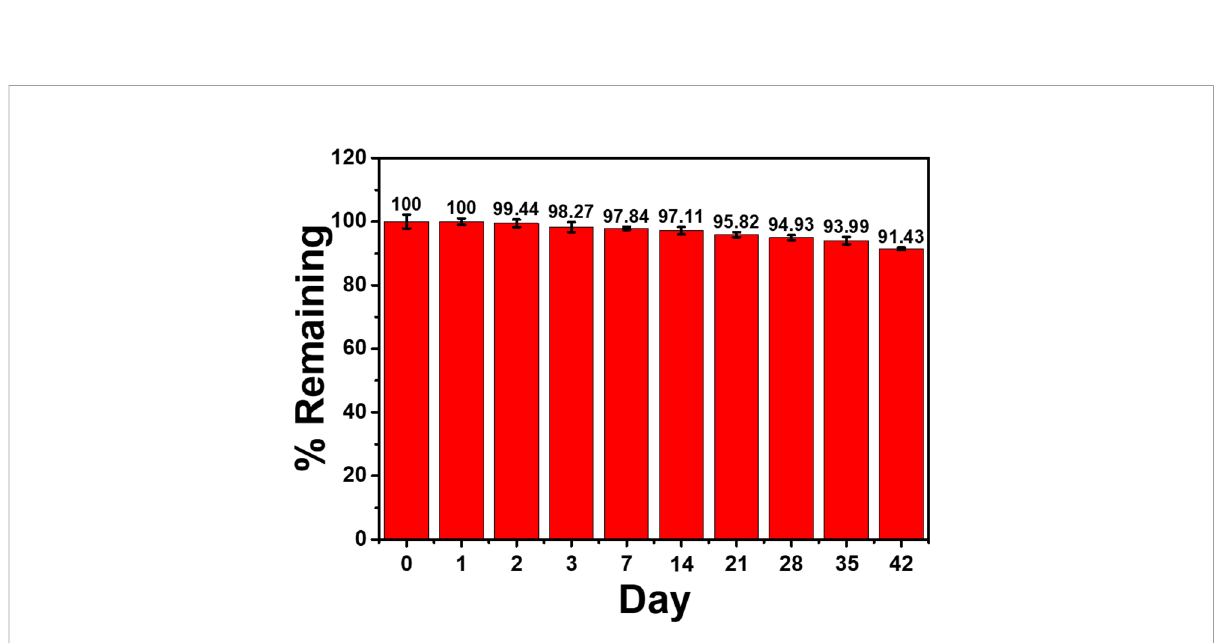
FIGURE 9 Stability of the electrochemical immunosensor in the detection of AFP.